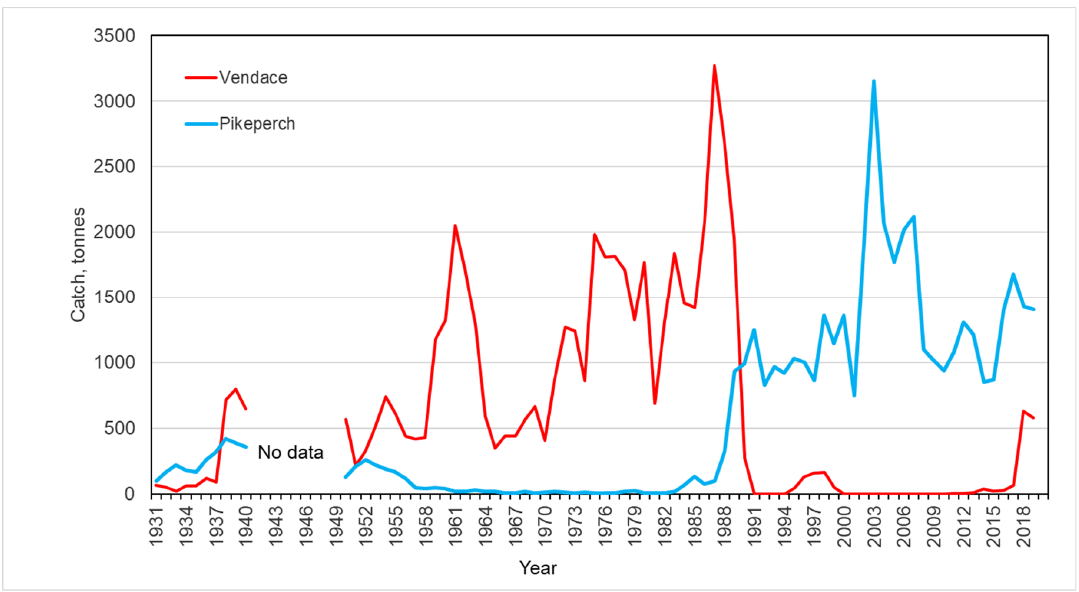
Figure 2. Long-term changes of selected lake surface water temperature (LSWT) parameters in Lake Peipsi: ( a ) .ean LSWT (°C) of 1–100 Julian days; ( b ) ice-off date-first Julian day when LSWT exceeded 1 °C; and ( c ) first day when LSWT exceeded 17 °C (Julian day). Cubic regression curves predict the parameter values for different times (continuous line). The 95% confidence limits for predictions are shown by dashed lines. The regressions presented by lines are significant (p < 10 −6 ). The year of vendace collapse is marked with “ ”.